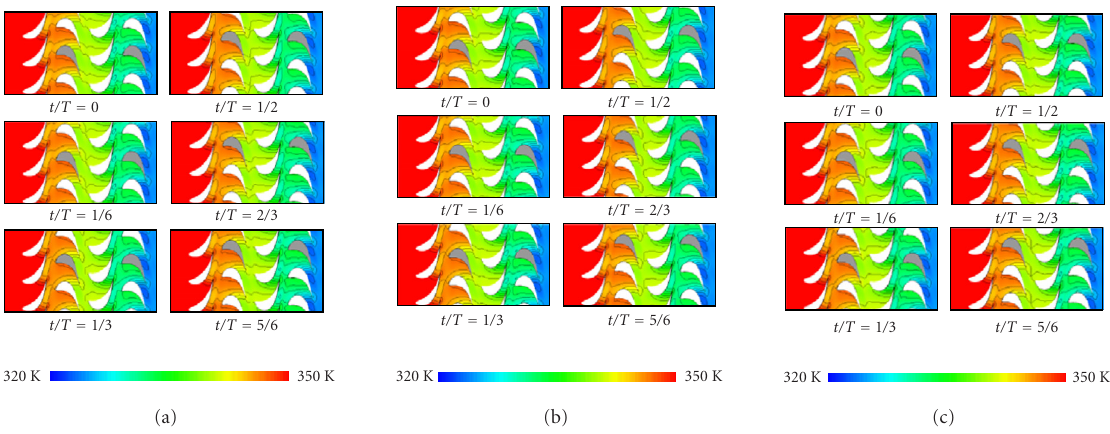
Figure 6: Absolute temperature distributions in the unsteady calculation (sliding mesh approach): (a) clocking position s1, (b) clocking position s2, and (c) clocking position